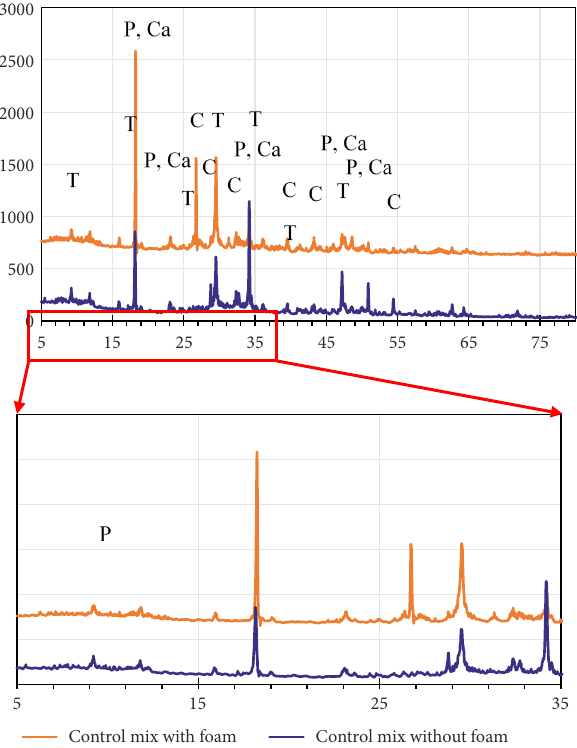
Figure 11. X-ray diffraction of the control foamed concrete and mortar; where P is portlandite, Ca is calcium hydroxide (Ca(OH) 2 ), C is coesite and T is tobermorite